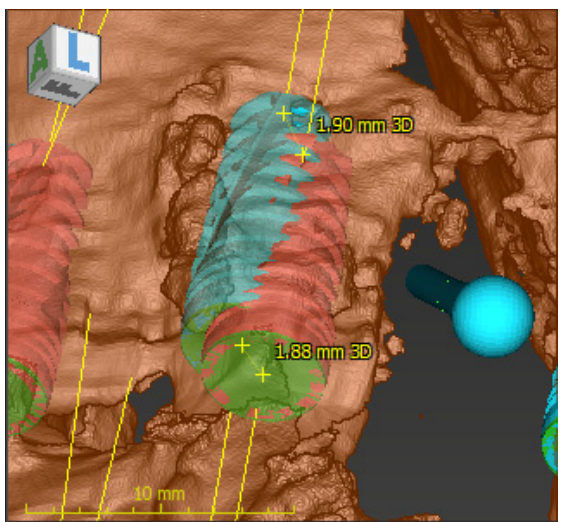
Figure 3. Measuring the primary outcome variables in the Treatment Evaluation plug-in of coDiagnostiX software, version 10.2 (Dental Wings, Montreal, CA, USA).